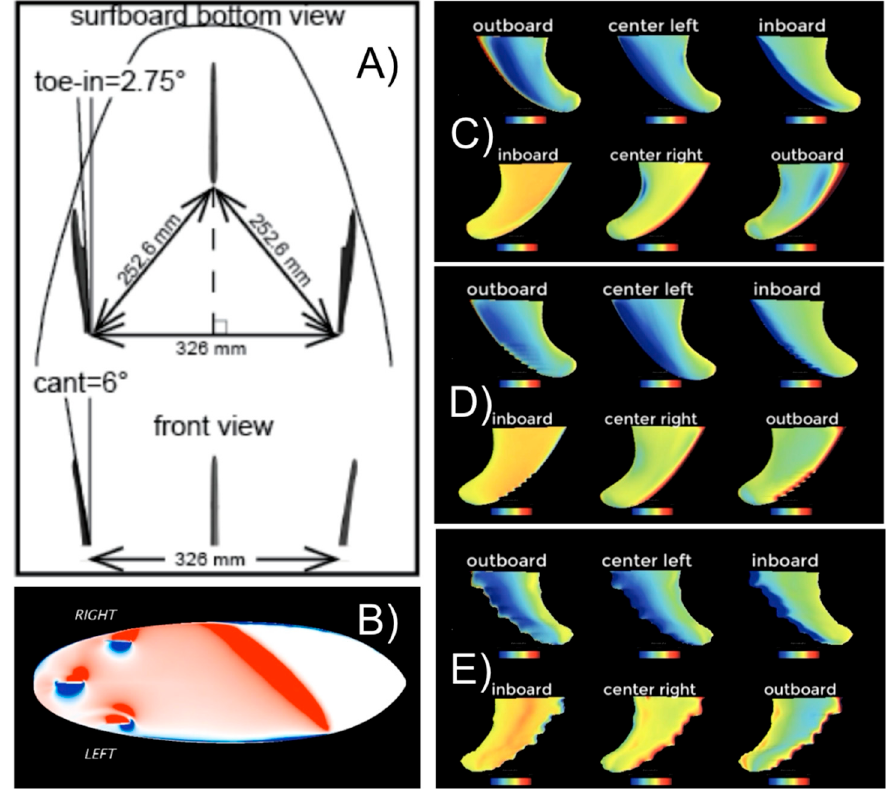
Figure 2. ( A ) Thruster fin positioning used in simulations. Toe-in refers to the angle the thruster fins are turned towards the nose. ( B ) Bottom of the board with thruster set of fins. Profiles of the fins with surface features: ( C ) control fins, ( D ) CR fins with grooves and ( E ) RW fins with tubercles. Dimensions of fins are detailed in Table S2. Images shown in ( B – E ) are snapshots from dynamic simulations of cutbacks, with colors referring to pressure values (see Supplementary Information Videos